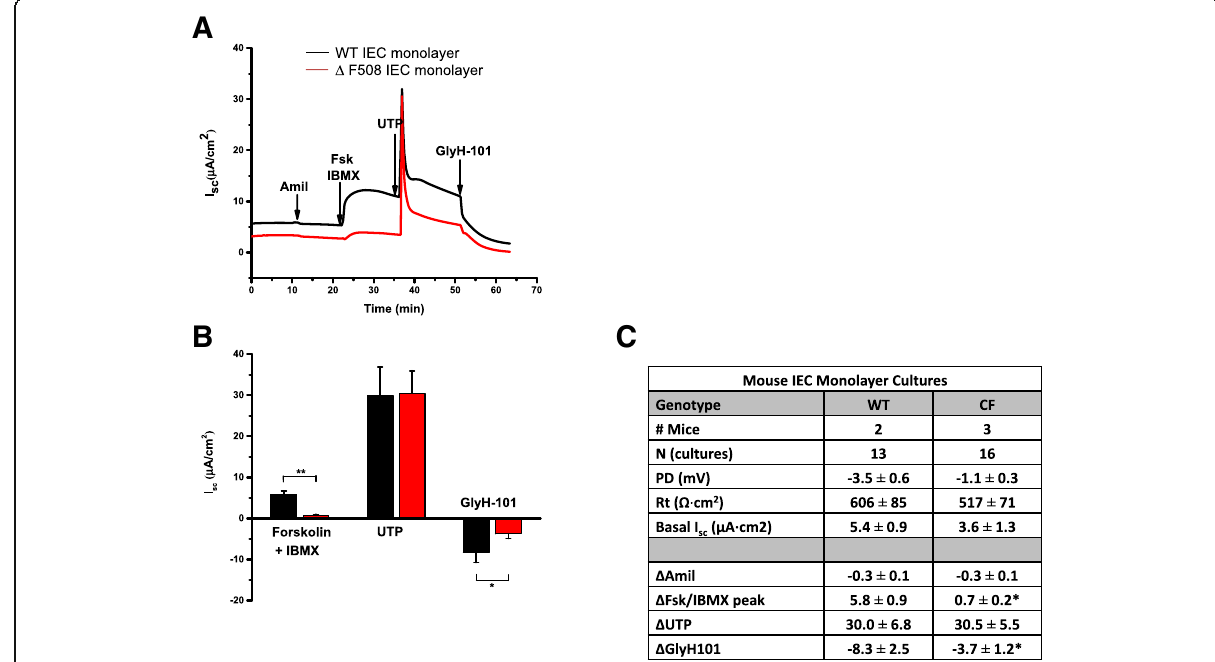
Fig. 4 Electrophysiological measurements of WT and CF mouse IEC monolayers. a Representative traces of electrophysiological measurements of WT and CF mouse IEC monolayers in Ussing chambers. Amiloride (Amil), Forskolin + IBMX (Fsk/IBMX), UTP and GlyH-101 were added sequentially. b Mean Forskolin/IBMX, UTP and GlyH101 responses measured in Ussing chambers. Electrophysiological measurements were performed on IEC monolayers derived from 2 individual WT mice and 3 individual Δ F508 CFTR mice. c Measured bioelectric characteristics of WT and CF IEC monolayer mouse small intestinal cultures. Basal potential difference (mV), transepithelial resistance ( Ω x cm 2 ), and current ( μ A/cm 2 ) are reported. Data represented at mean ± SEM based on cultures. * p <